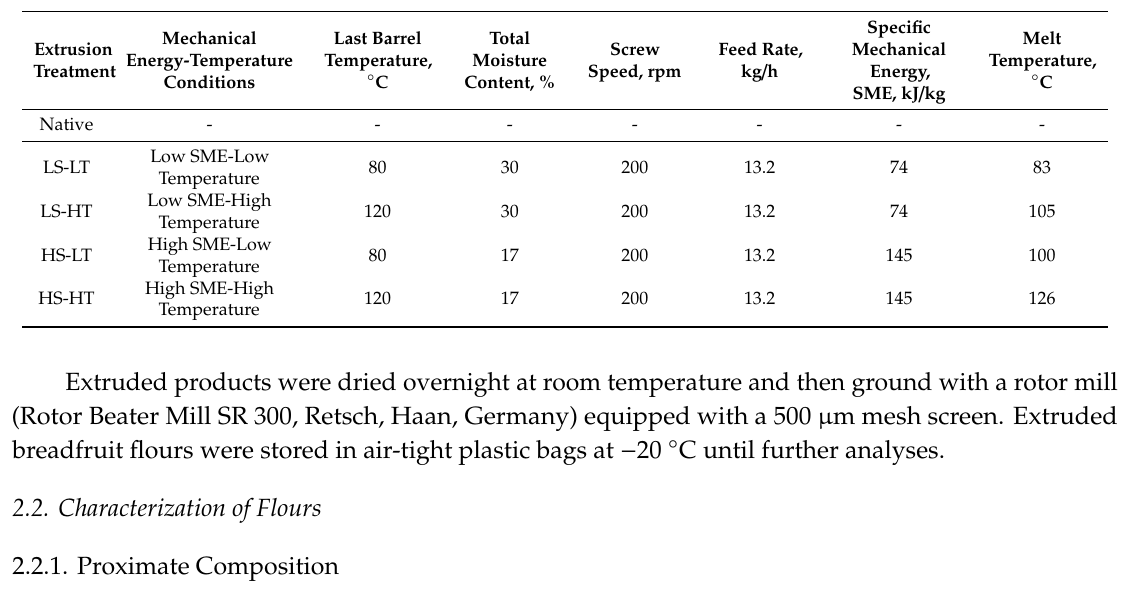
Table 1. Extrusion conditions applied to breadfruit